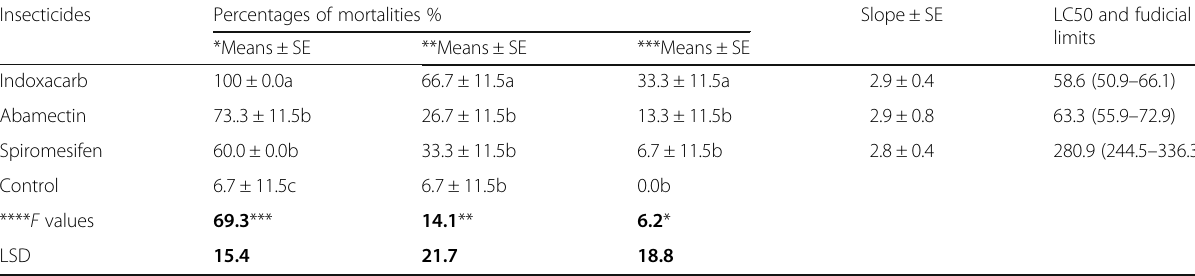
Table 2 Toxicity of tested pesticides against the adults of chocolate banded snail, E . vermiculata Insecticides